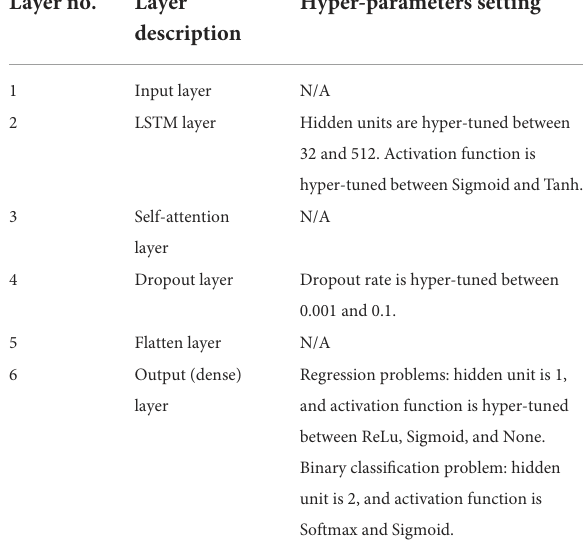
TABLE 1 Proposed model